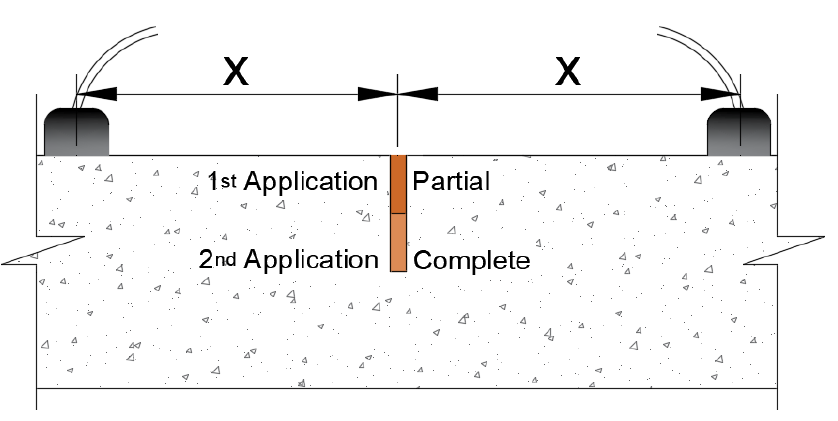
Figure 5. Stages of application of epoxy repair